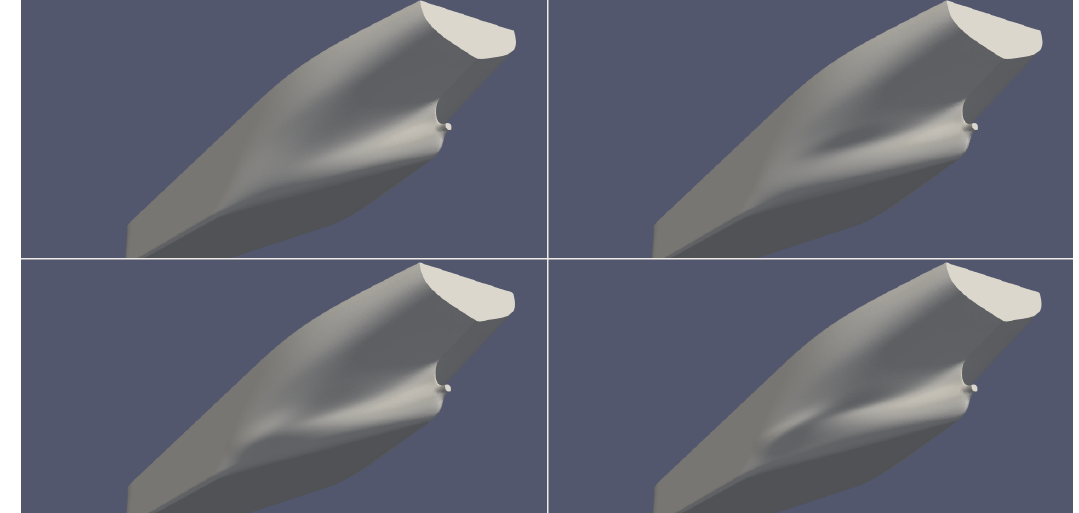
Figure 8. Comparison of the original hull shape ( top left ) and three Pareto optimal solutions: the best for the first objective function ( top right ), a solution with the best balance between the two objectives ( bottom left ) and the best for the second objective ( bottom right ).